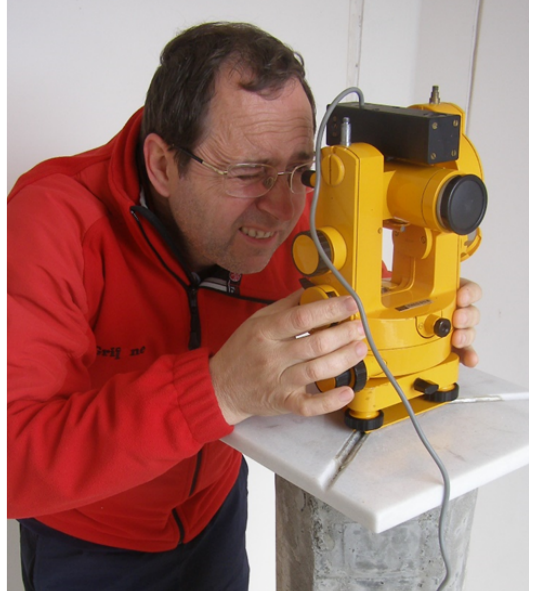
Figure 2. The manual declination and inclination (D/I) fluxgate theodolite being manipulated by a specialist. More details about the sensor can be found in [9].